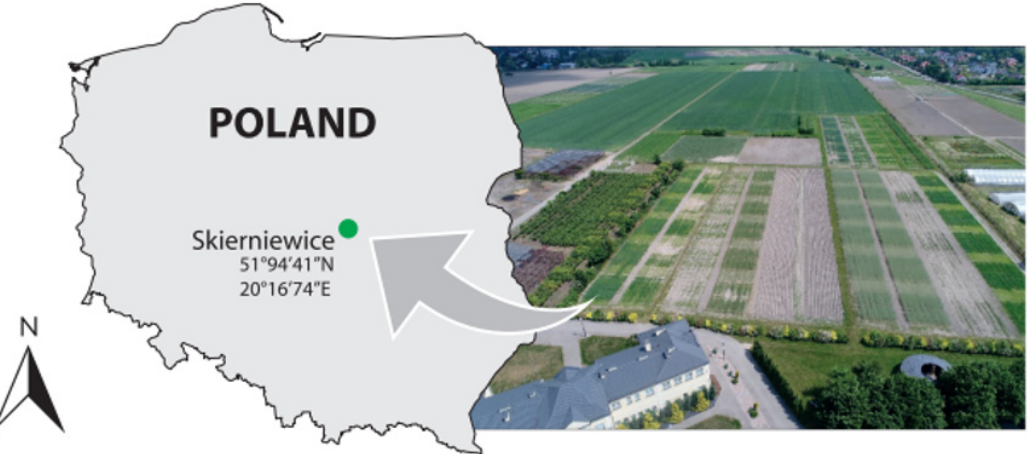
Figure 1. Location of the experimental station in Poland.